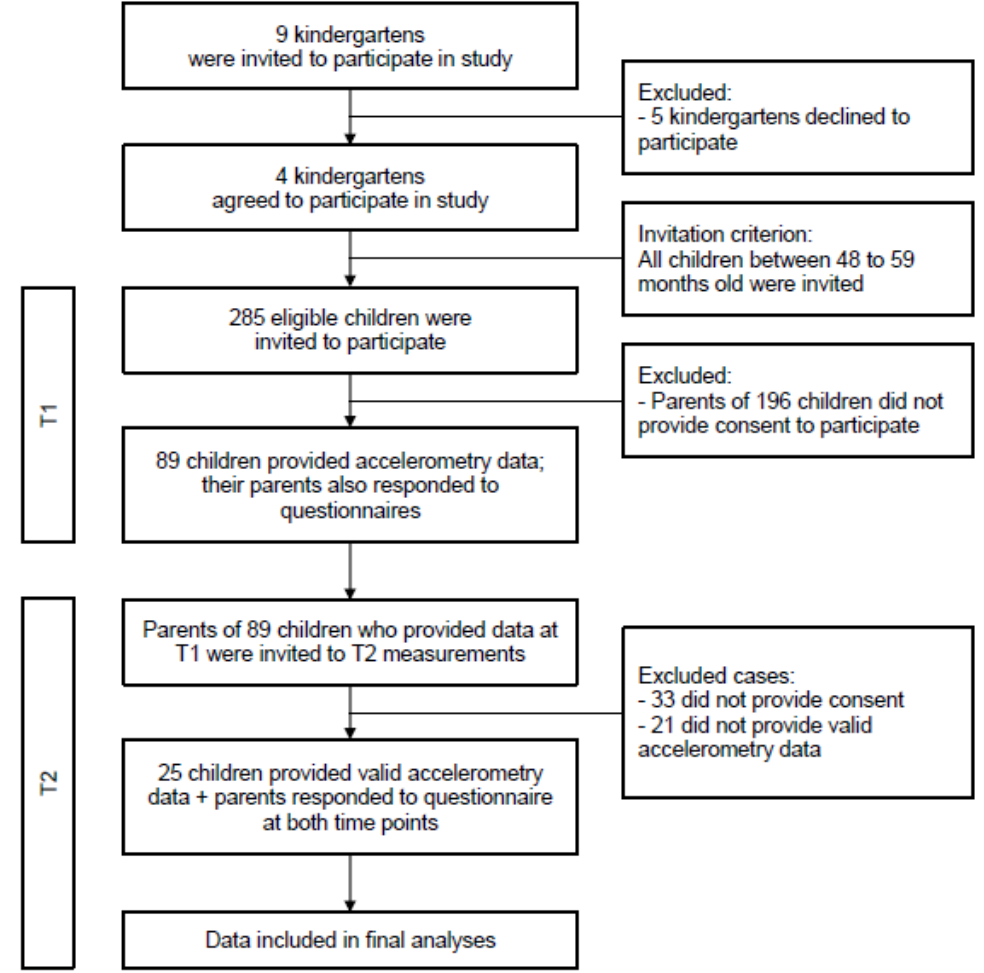
Figure 1. Flow diagram showing how the dataset used for analyses was derived.